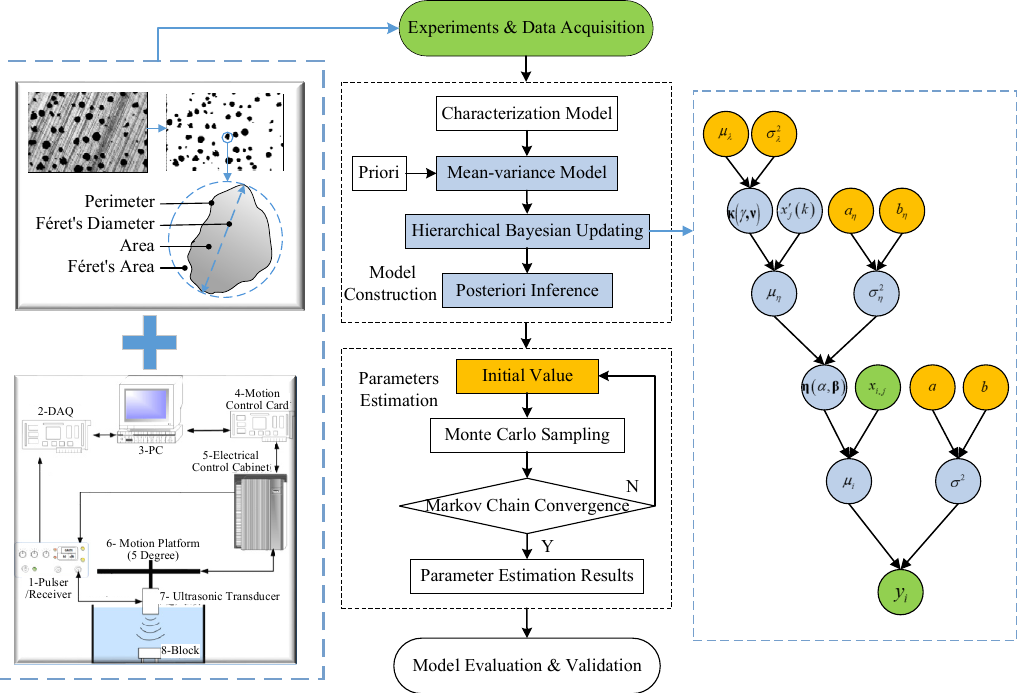
Figure 1. (Color Online) Flow diagram of ultrasonic benchmarking for microstructure characteriza- tion using hierarchical Bayesian regression model. Note: The green containers represent the exper- imentally collected data; the orange containers represent their prior distributions that must be input during modeling; and the blue containers contain their posterior distributions that must be esti- mated.